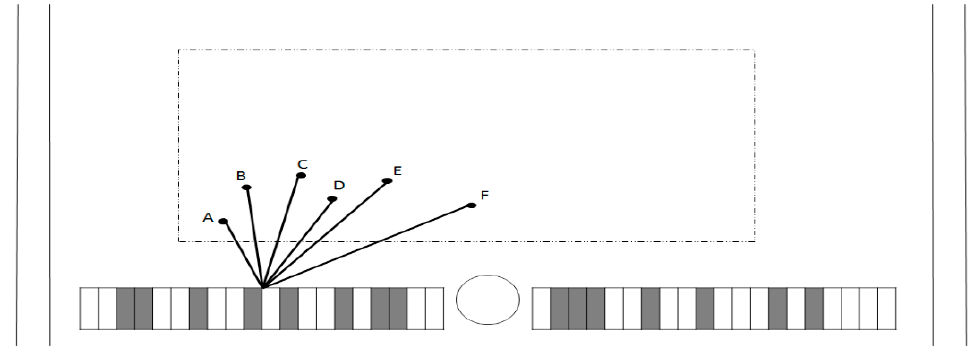
Figure 16. Feeder slot and the first component.